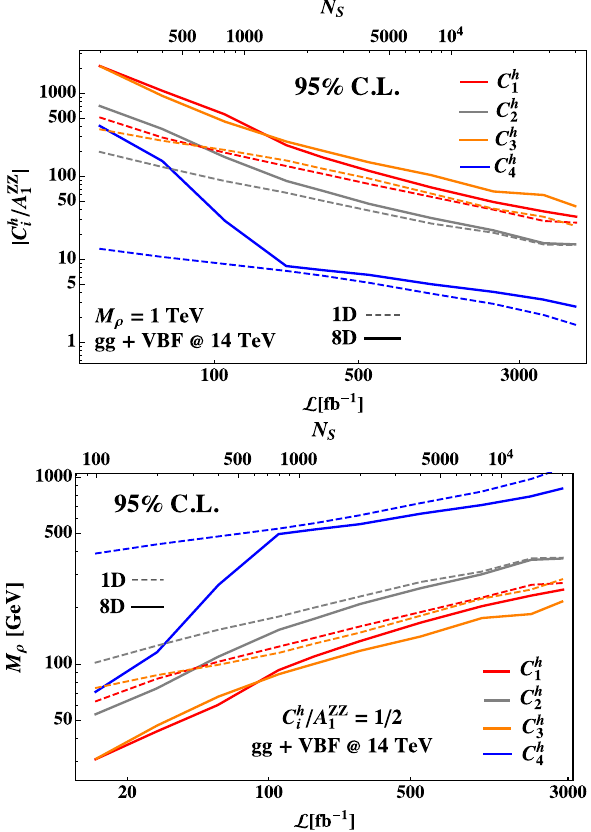
/ A ZZ usingshapeinforma- i 1